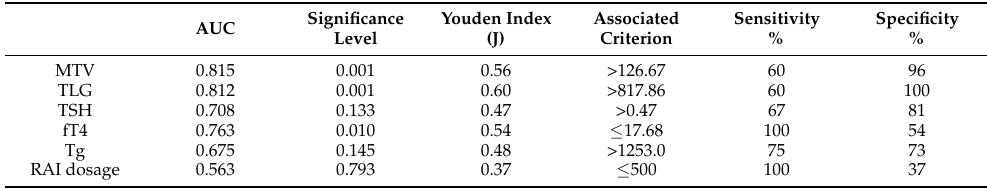
Table 4. Table reporting the results of ROC curves analysis performed on all variables with respect to 1-year-survival. As regards the associated criterion, values are to be expressed in cm 3 for the MTV, mU/L for the TSH, pg/mL for the fT4, ng/mL for the Tg, and mCi for the RAI dosage.